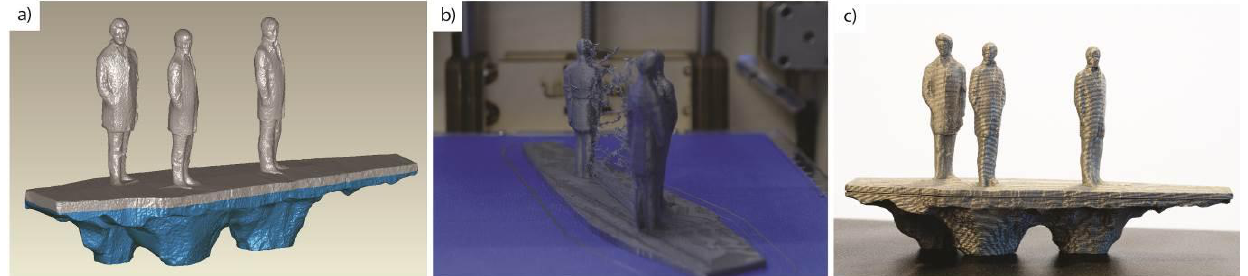
Figure 9. ( a ) Both parts of the completed mesh model, with the lower part shown in blue, ( b ) the top part of the model in the ELRP machine; ( c ) and the completed physical model.